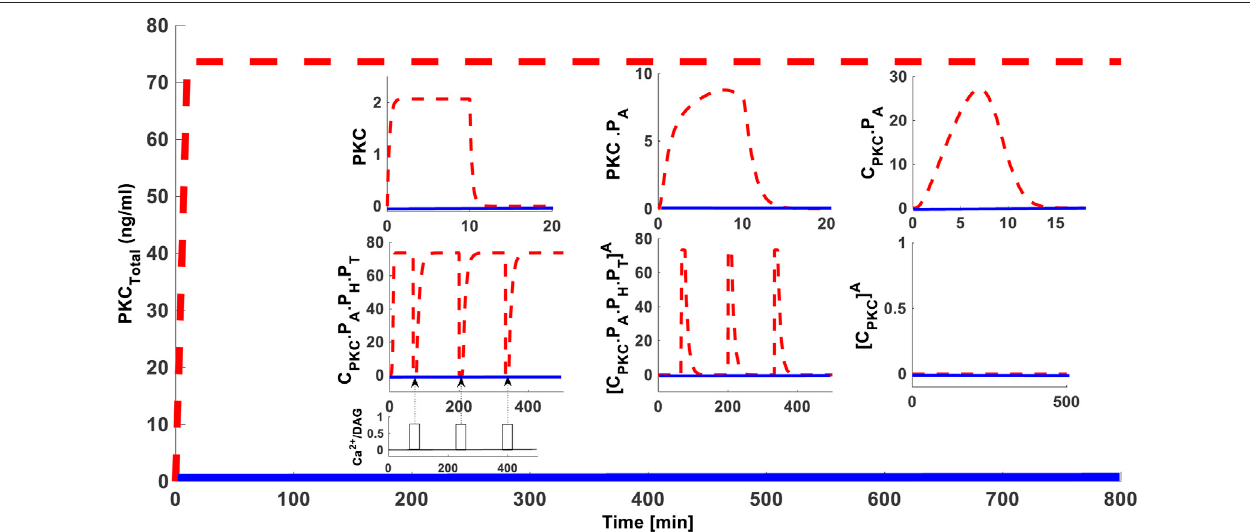
FIGURE4 | The effect of100% blocking ofdephosphorylation rate i.e., “ k 17 ” , on the cPKC lifecycle.Theseresults show that 100% blocking of dephosphorylation ratepreventsthedown-regulationoftotalPKC,evenathigherstimulationlevels.Here,applicationofinitialproteinsynthesisstimulationleadstothequickgenerationand constitutive stabilization of cPKC enzymes. After initial protein synthesis stimulation three identical pulse stimulations of second messenger DAG are applied at time points t= 4,000 s; t= 12,000 s;and t= 20,000 s.Each ofthesepulse stimulations is applied for 15 min and during their applicationthe dephosphorylation rate k 17 was completely blocked. These results indicate that blocking the dephosphorylation did not result in the down-regulation of total PKC enzyme as well as the CPKC.P A .P H .P T . The inset shows that application of a second messenger stimulation results in decrease of CPKC.P A .P H .P T and increase in PKC A but after second messenger is removed the CPKC.P A .P H .P T levels are restored indicating that down-regulation is very much dependent on the dephosphorylation pathways.